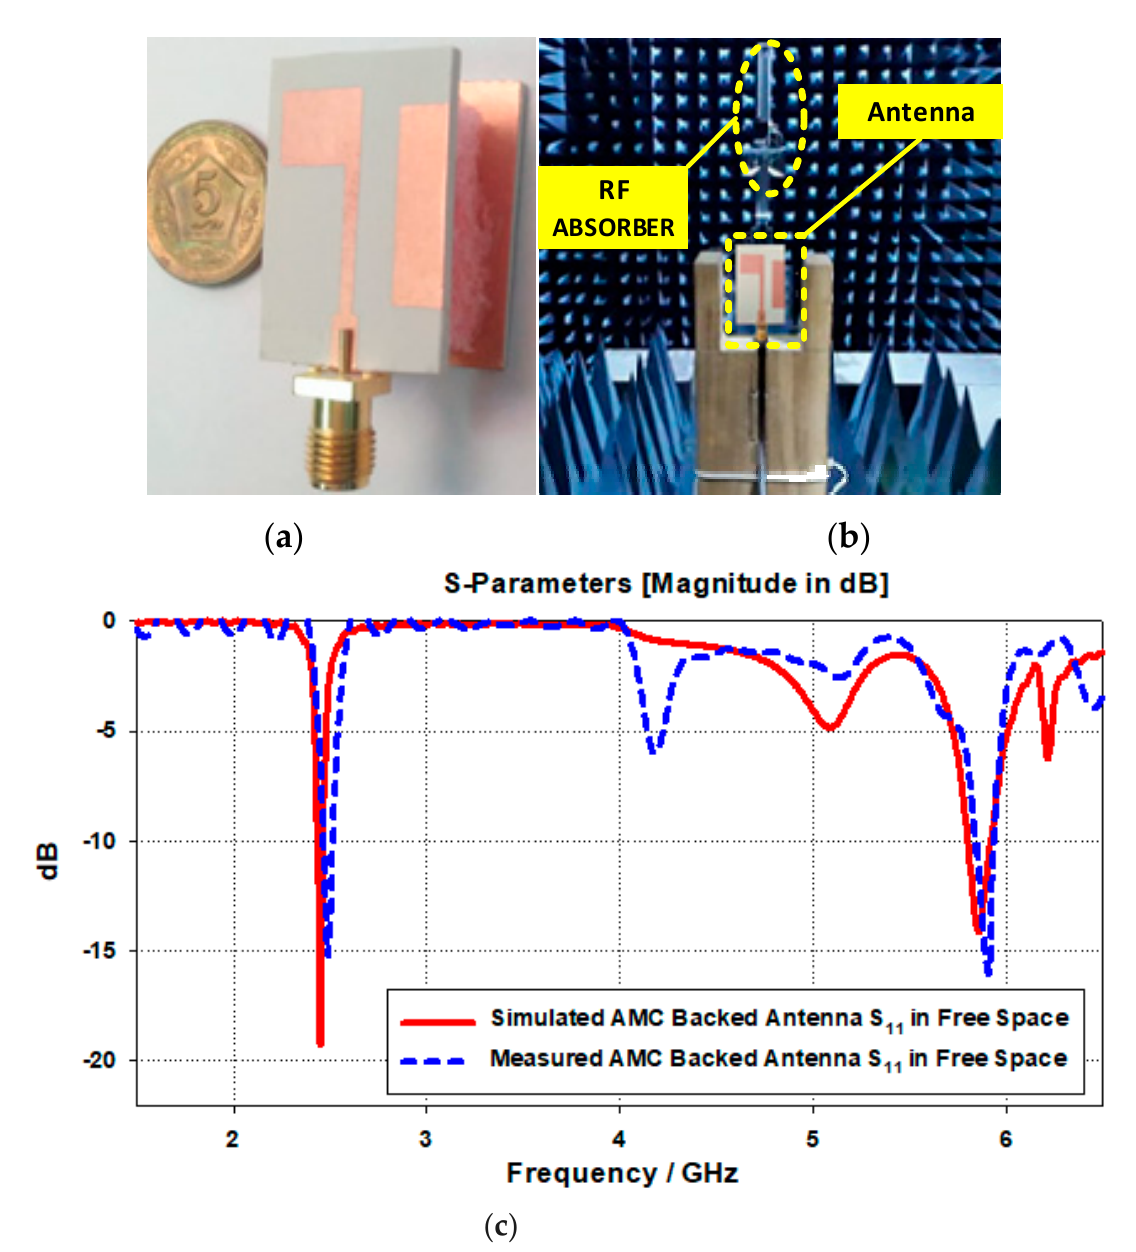
Figure 24. ( a ) Fabricated prototype of the AMC-backed antenna; ( b ) evaluation setup in an anechoic chamber; ( c ) comparison of measured and simulated reflection coefficients of the AMC-backed antenna in free space. Figure 25 depicts the antenna simulated radiation pattern represented by a solid black line, whereas the antenna measured results are represented by a dotted red line with the unit cell in free space. As can be seen from the pattern, the radiation patterns are